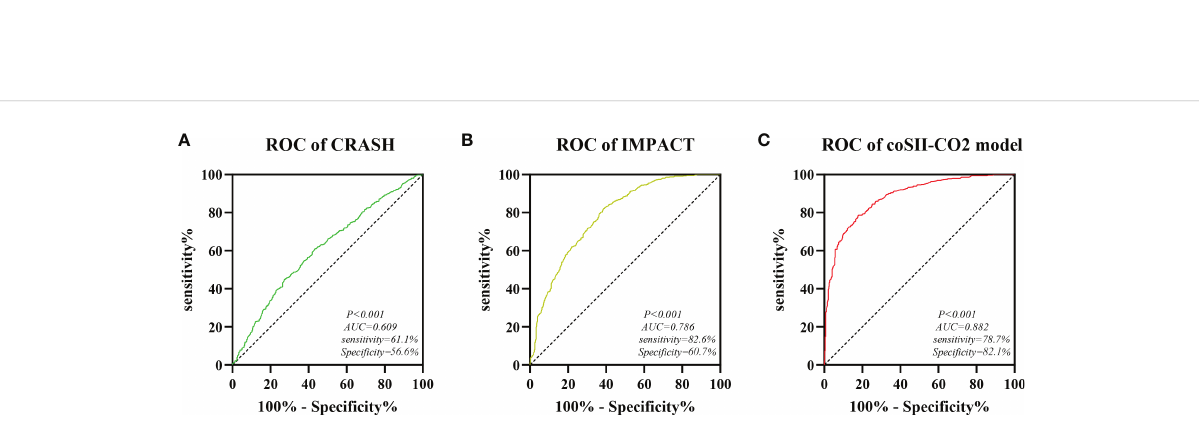
FIGURE 8 Comparison of predictive performance between CRASH, IMPACT and coSII-CO2 models. (A) The AUC value of CRASH is 0.609. (B) The AUC value of IMPACT is 0.786. (C) The AUC value of coSII-CO2 is